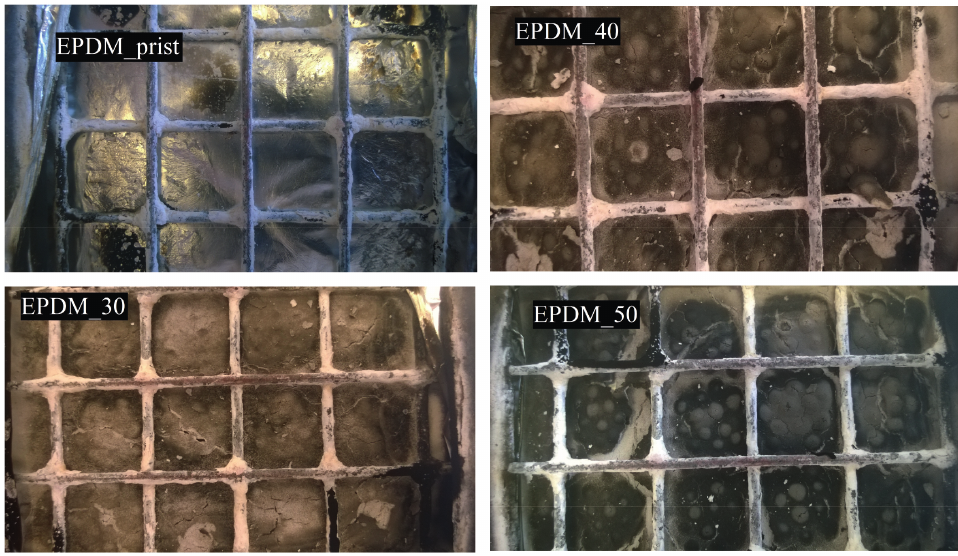
Figure 8: Photographs of samples studied residue after cone calorimetry test.